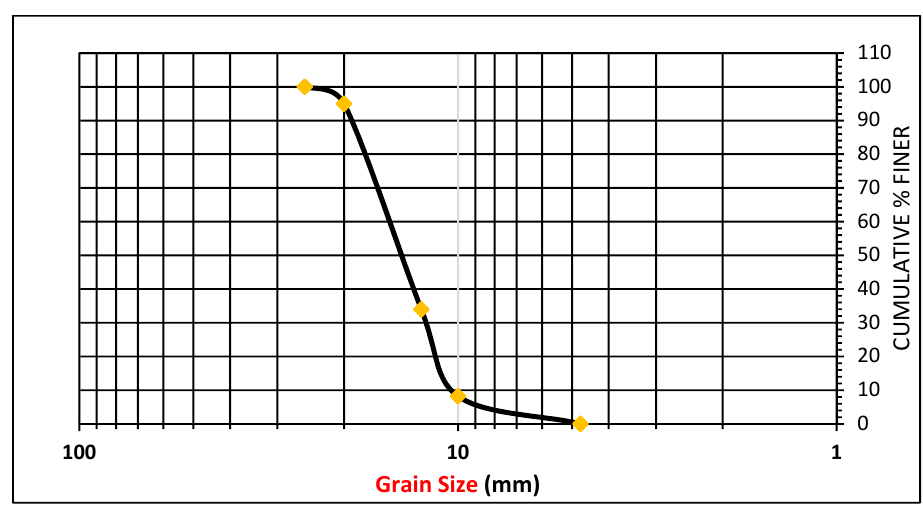
Figure 1. Fine aggregate sieve analysis.